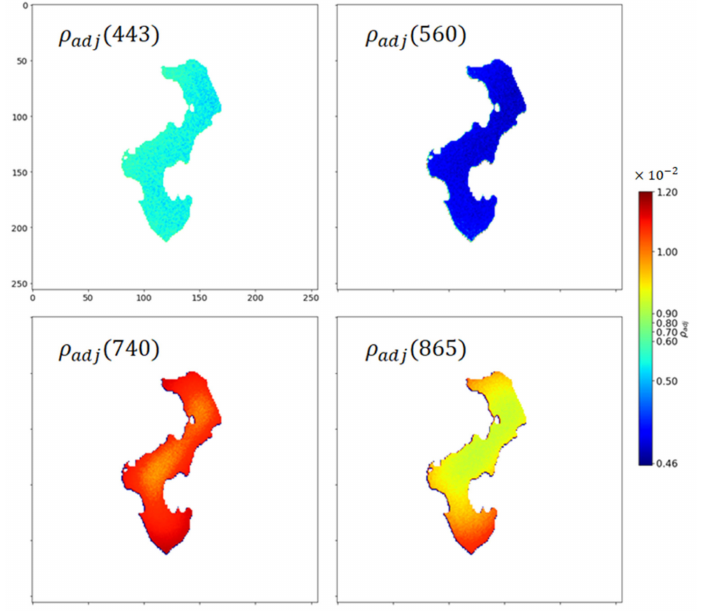
Figure 16. Map of the adjacency reflectance ρ adj of part wavebands (443 nm, 560 nm, 740 nm, and 865 nm) over the